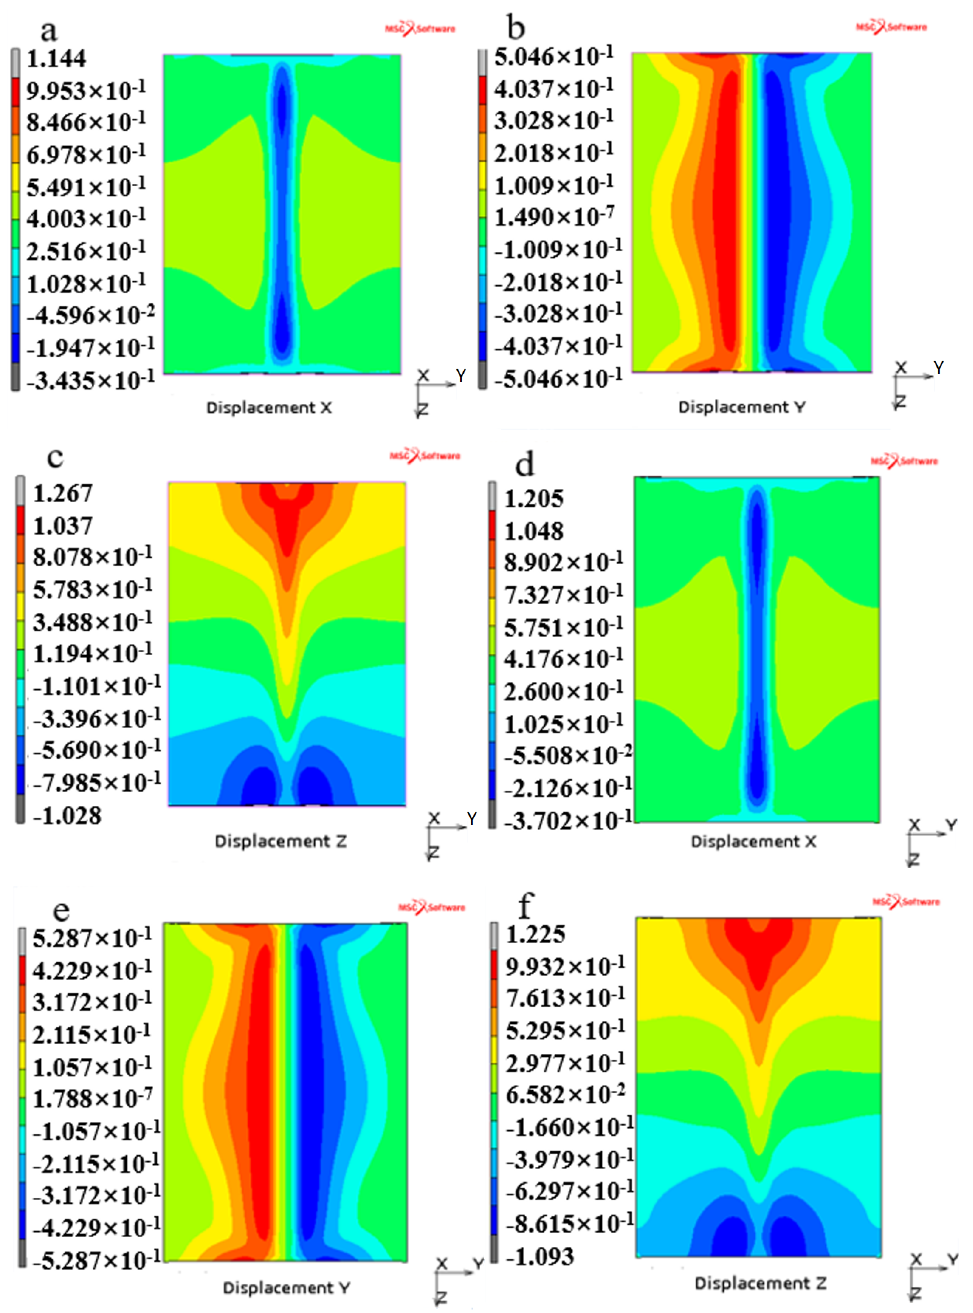
Figure 13. Welding deformation. ( a – c ) the deformation of the first welding method in X , Y , and Z -directions, ( d – f ) the deformation of the second welding method in X , Y , and Z directions.